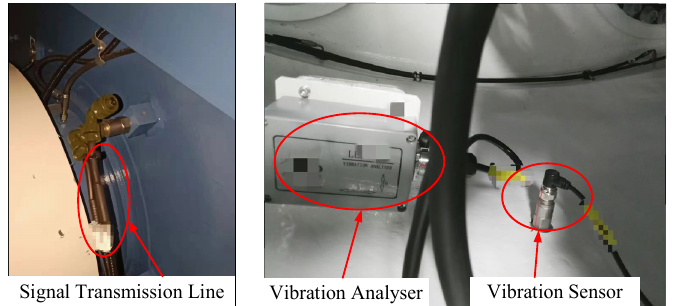
Figure 5. Signal acquisition.